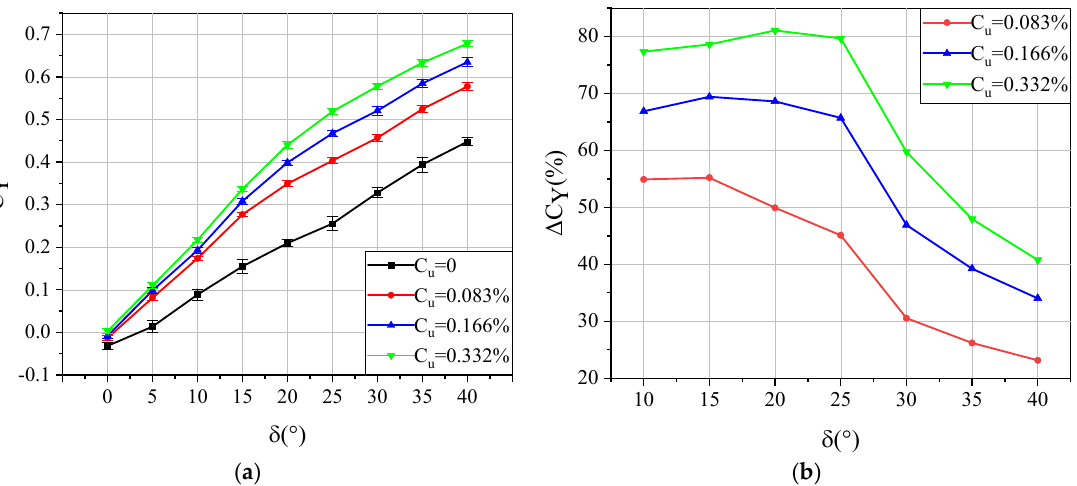
Figure 12. Lateral force coefficient and increment of vertical tail model under different momentum coefficient controls: ( a ) lateral force coefficient curves; ( b ) lateral force coefficient increment curves ( β = 0°, Re = 2.12 × 10 5 ).